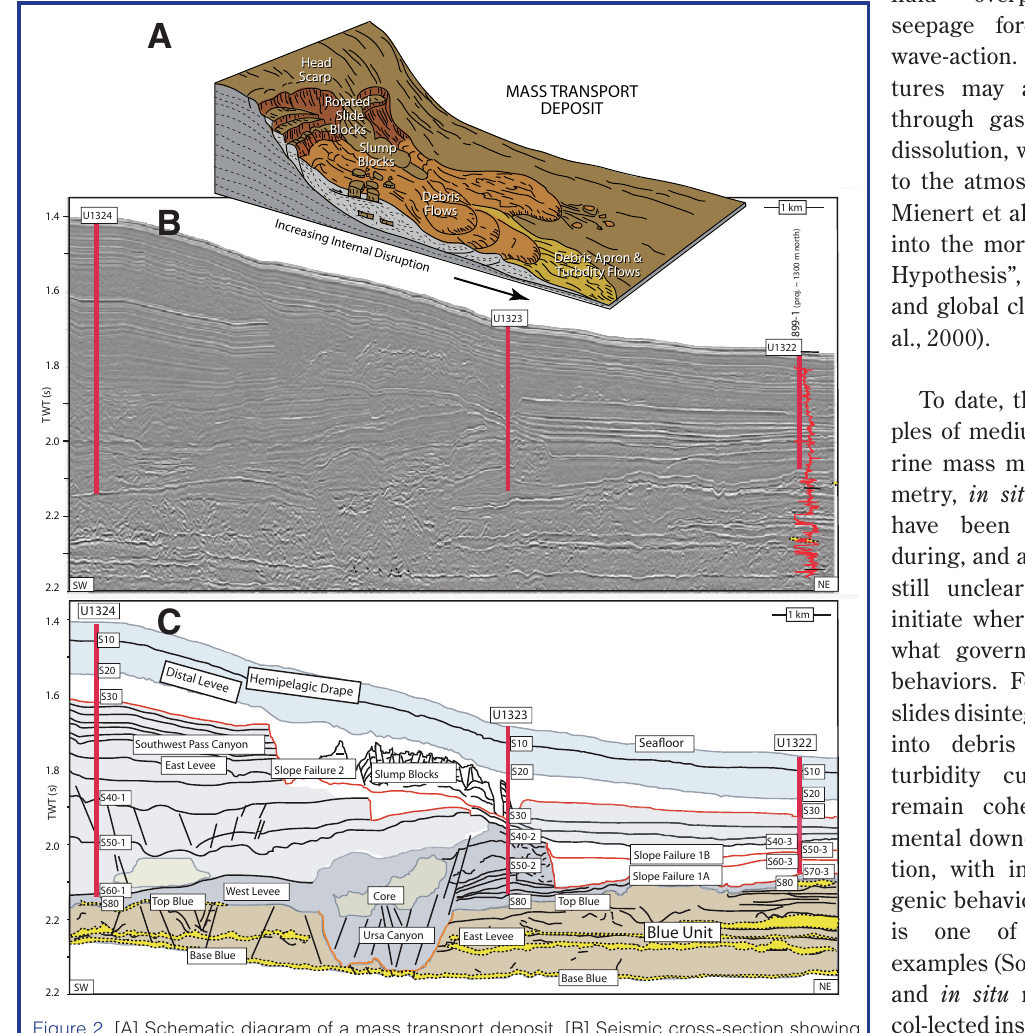
Figure 2. [A] Schematic diagram of a mass transport deposit. [B] Seismic cross-section showing stacked submarine slides/slumps within the Ursa region of the northern Gulf of Mexico. Some of the failures show low-amplitude, discontinuous reflections; others show distinct dipping reflectors suggesting block rotation. [C] Interpreted cross-section identifying key lithologic units and fea- tures. Blue Unit is a sand-prone layer. B and C modified from Flemings et al.